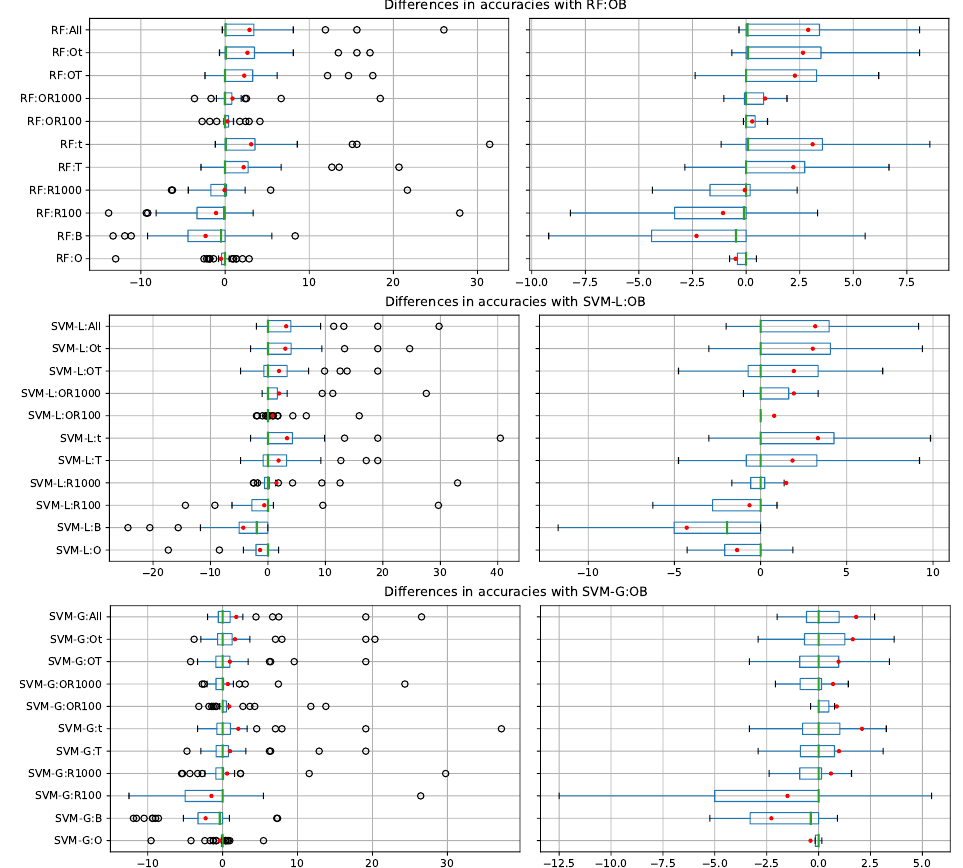
Figure 4. Boxplots of the differences in accuracy between the different feature sets and the feature set (OB), for the three considered classifiers. The boxplots on the right do not include the outliers. The average differences are marked with a red dot ( • ).